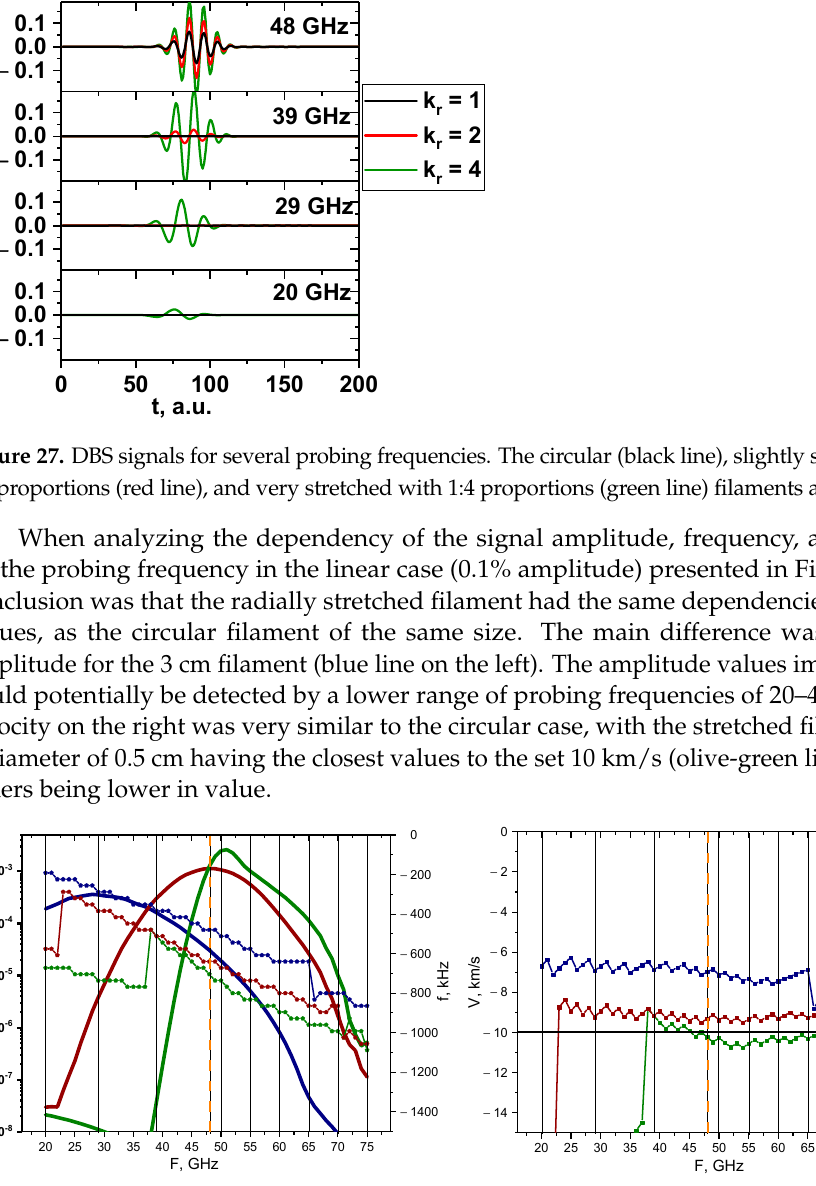
Figure 28. For the radially stretched filament with an amplitude of 0.1%: ( left ) dependency of the DBS signal amplitude (bold lines with scale on the left) and frequency (lines with pentagon shapes with scale on the right) on the probing frequency; ( right ) dependency of the calculated velocity on the probing frequency. The navy-blue lines are the circular filament with a 3 cm diameter, the wine-red are that of 1.5 cm, and the olive-green are that of 0.5 cm. The black vertical lines indicate the probing frequencies available in Globus-M2, and the vertical orange dashed line indicates the position of the filament at cutoff of the 48 GHz probing wave. The horizontal line marks the set 10 km/s filament velocity.